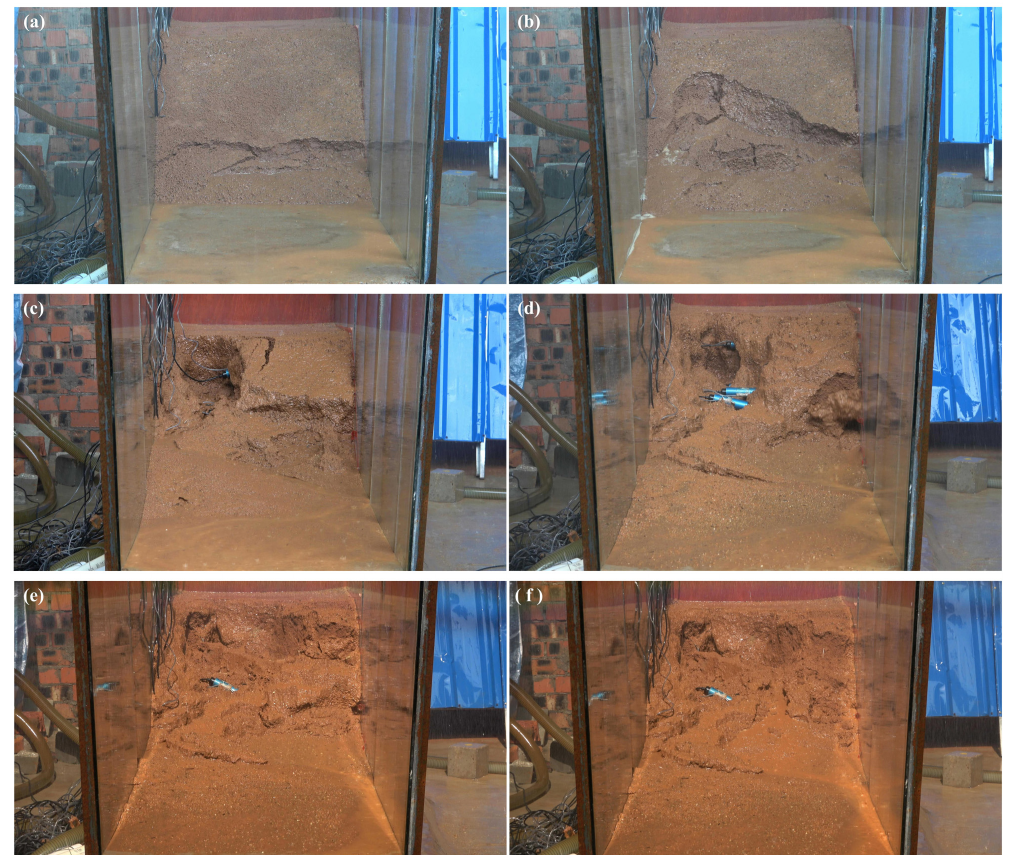
Figure 5. Typical phenomena of test 3. (a) The soil at the slope toe begins to slip after tensile cracks appear. (b) The soil in the middle slope slides. (c) The soil on the slope shoulder slips owing to unbalance internal forces. (d) Blocky soil slides suddenly on the right slope toe. (e) Massive soil on the right slope shoulder slides due to the unloading effect of the slope toe. (f) The slope is stable at the end of the